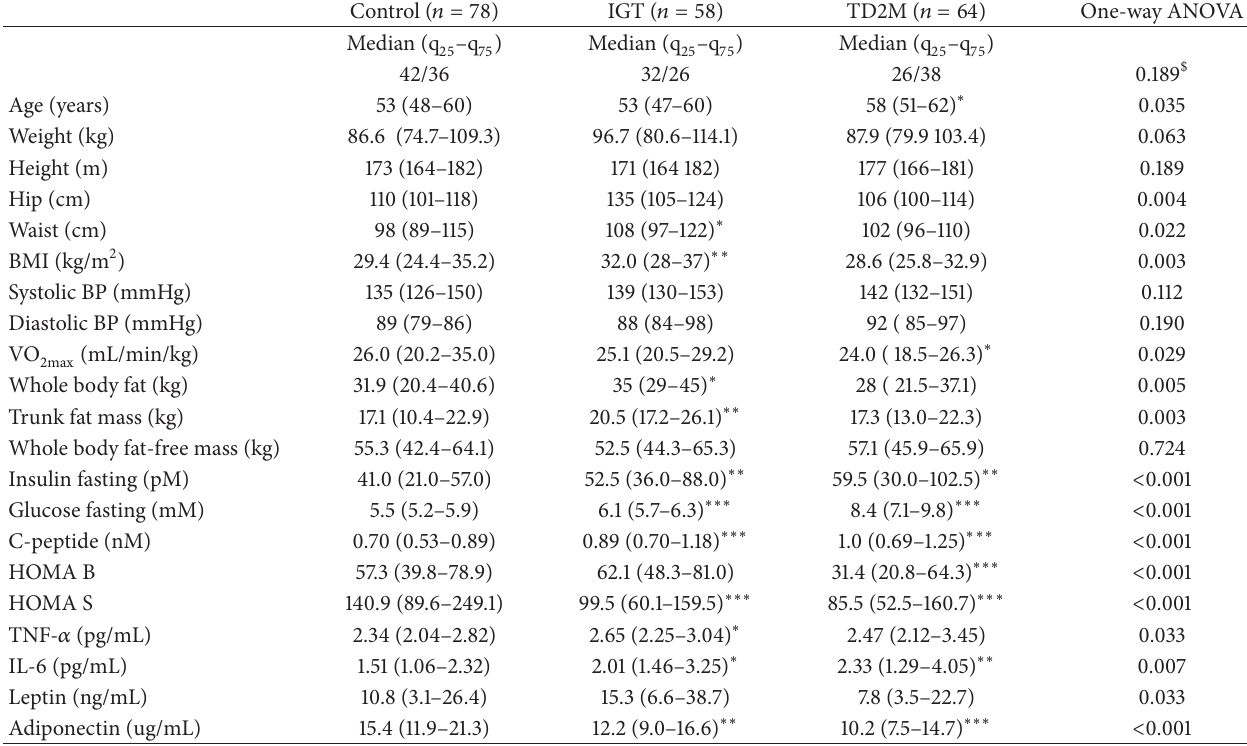
Table 1: Subjects’